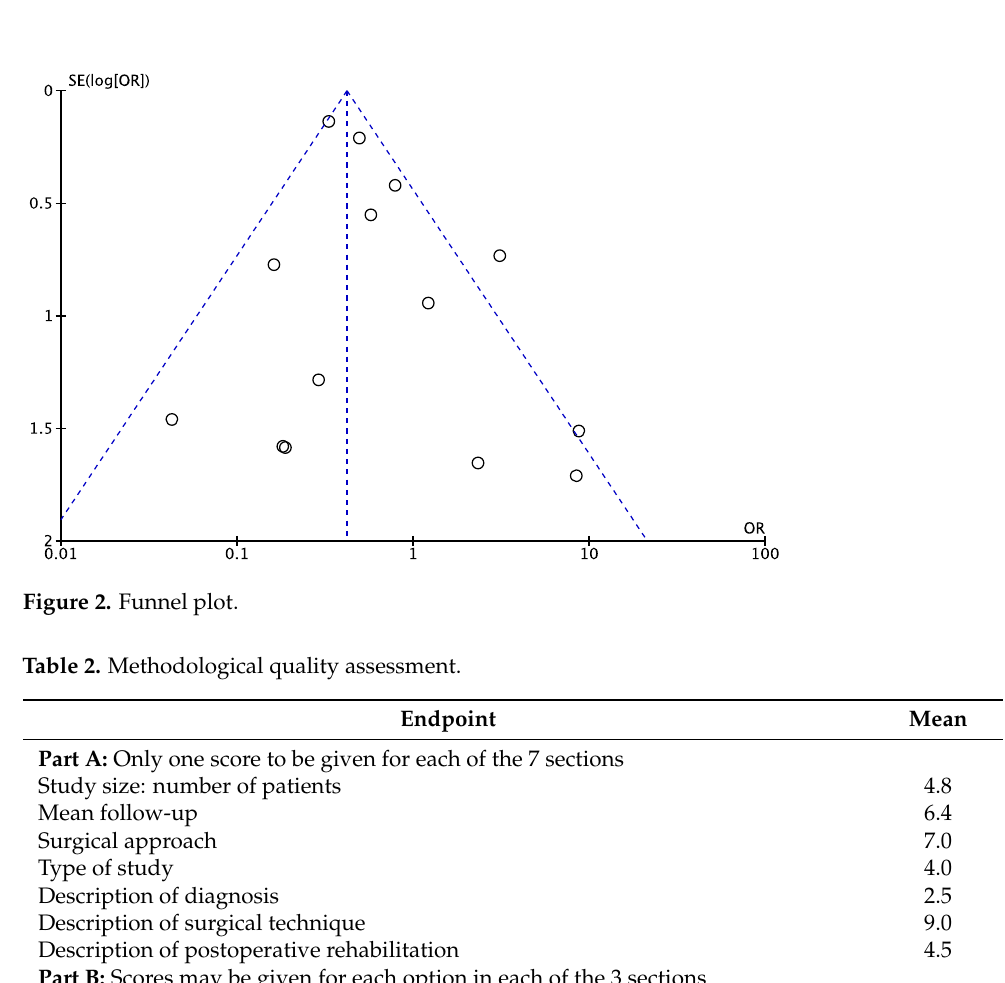
Table 2. Methodological quality assessment.